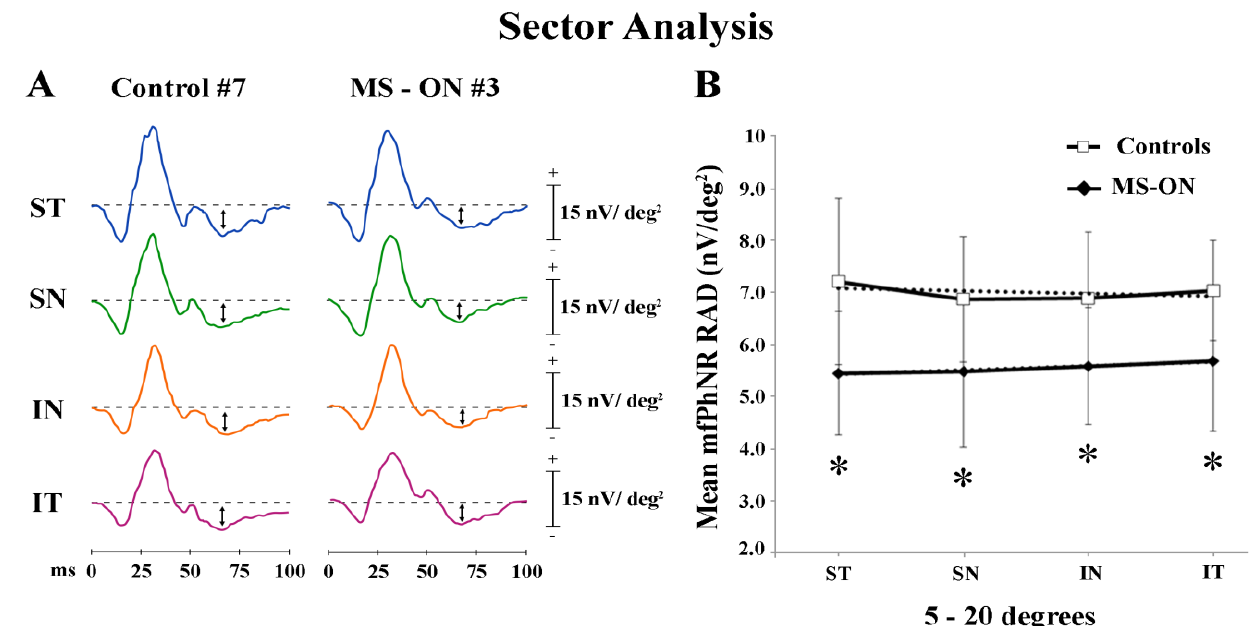
Figure 3. Multifocal photopic negative response (mfPhNR) sector analysis. ( A ) MfPhNR averaged are presented from a representative control eye (#7) and from an eye of a multiple sclerosis patient affected by optic neuritis (MS ‐ ON) (#3). The mean mfPhNR response amplitude density (RAD) measure is indicated by an arrow ( ↕ ). We analyzed five sectors covering an area of 20° of eccentricity from the fovea. The first sector (S1) corresponding to R1 (0–5°) is reported on Figure 1; the more external sectors (between 5° to 20°) were quarters of annulus, localized in the superior ‐ temporal (ST), superior ‐ nasal (SN), inferior ‐ nasal (IN), and inferior ‐ temporal (IT) areas with respect to the fovea. ( B ) Mean values of mfPhNR RAD (expressed in nanoVolt/degrees 2 , nV/deg 2 ) are plotted as a function sector analysis. Vertical bars represent one standard deviation of the mean values. Dashed lines indicate the linear fitting for mfPhNR RADs (controls: r 2 = 0.17, MS ‐ ON: r 2 = 0.96). The relative functions show almost constant values of mfPhNR RADs in both controls and MS ‐ ON eyes between sectors although the trend is actually linear only in the MS ‐ ON group. * indicates the statistically significant ( p < 0.01) difference between MS ‐ ON and control groups. The values of the statistical analysis are reported in Table 3. Table 3. Mean values of multifocal photopic negative response (mfPhNR) sector analysis between 5 to 20 degrees observed in controls (C) compared to multiple sclerosis patients with optic neuritis (MS-ON)